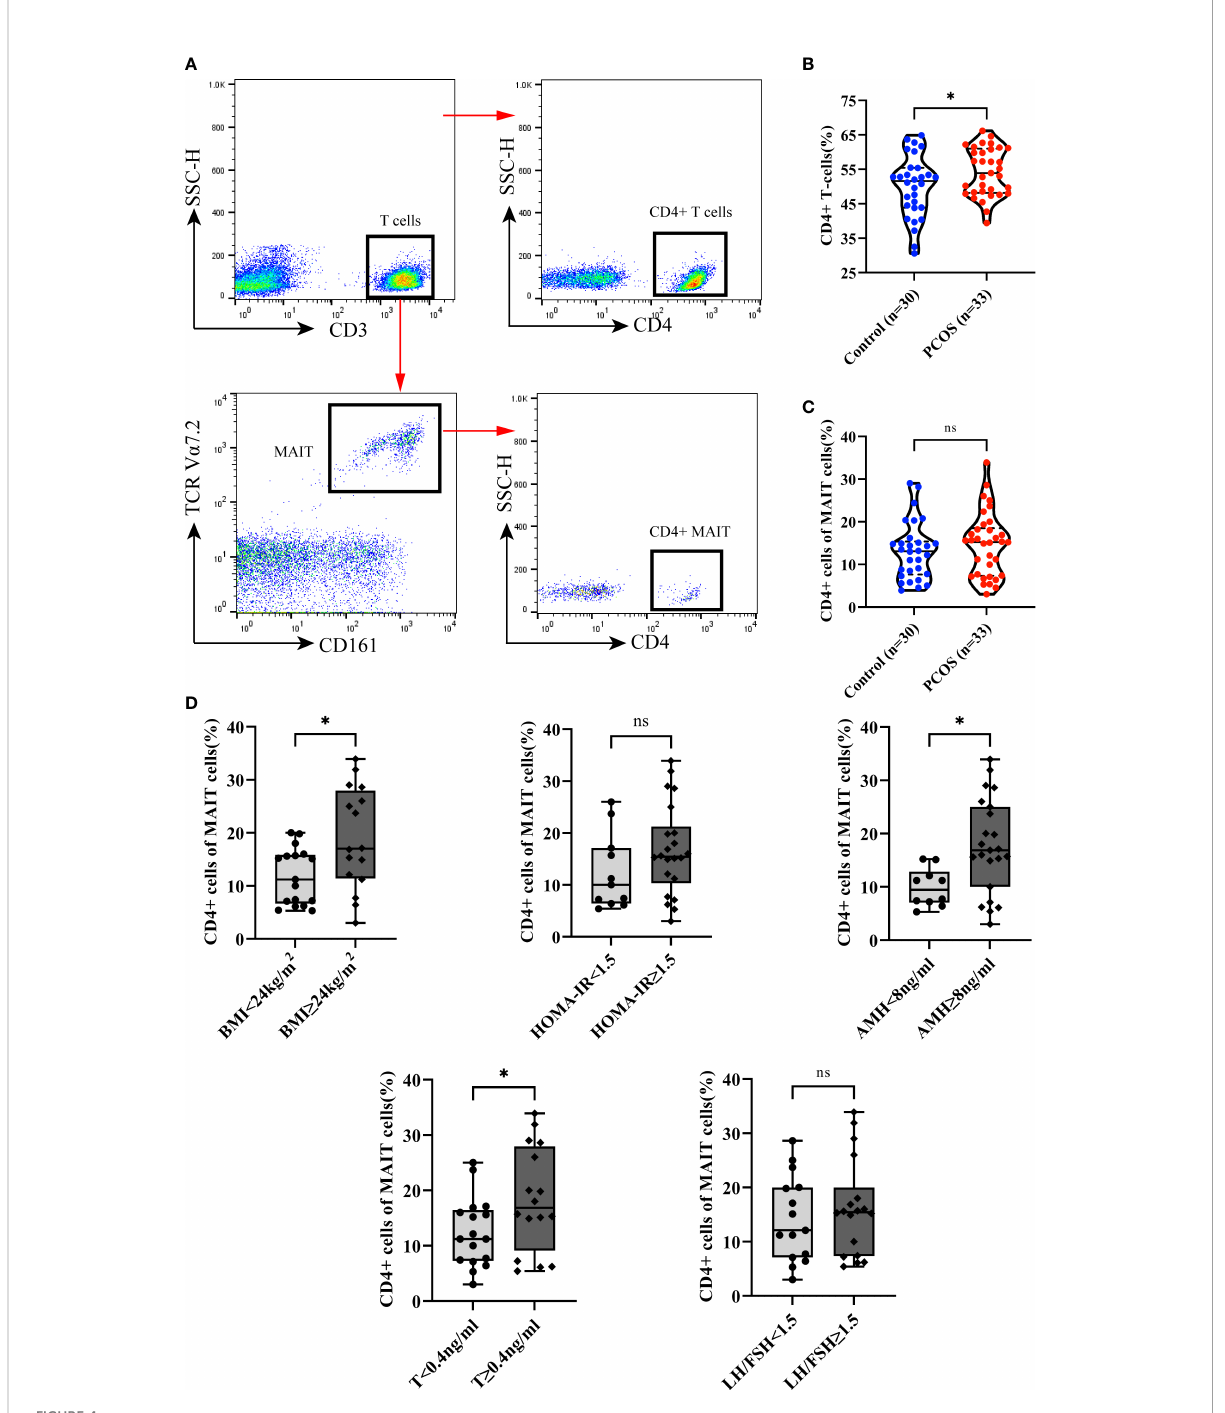
FIGURE 4 CD4+ cells of MAIT cells and T cells between Control and PCOS groups, and subgroup analysis of the CD4+ cells of MAIT cells in PCOS patients by BMI, HOMA-IR, AMH, T, and LH/FSH. (A) Gating strategy for CD4+ T cells (CD3+ CD4+) and CD4 MAIT cells (CD3+TCRV a 7.2 +CD161+CD4+). (B) CD4+ cells of T cells between Control and PCOS groups. (C) CD4+ cells of MAIT cells between Control and PCOS groups. (D) Subgroup analysis the CD4+ cells of MAIT cells in PCOS patients by BMI, HOMA-IR, AMH, T, and LH/FSH. *p<0.05, ns, not signi fi